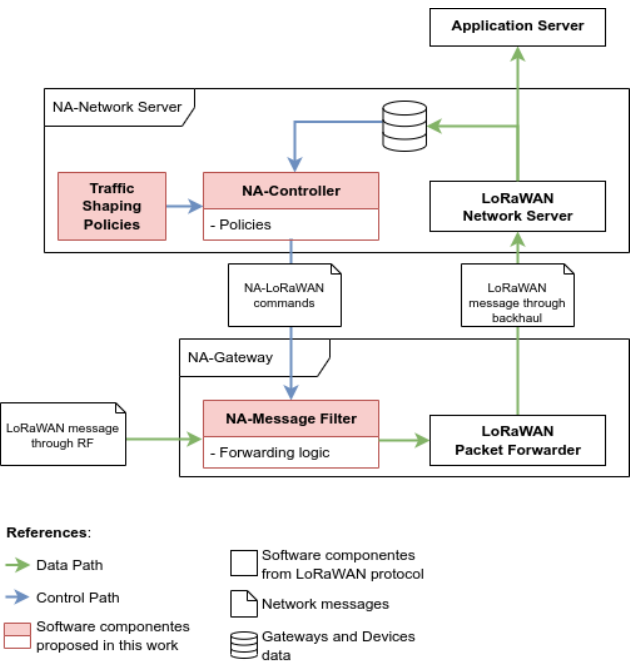
Figure 3. Communication process between the NA-gateway and NA-network